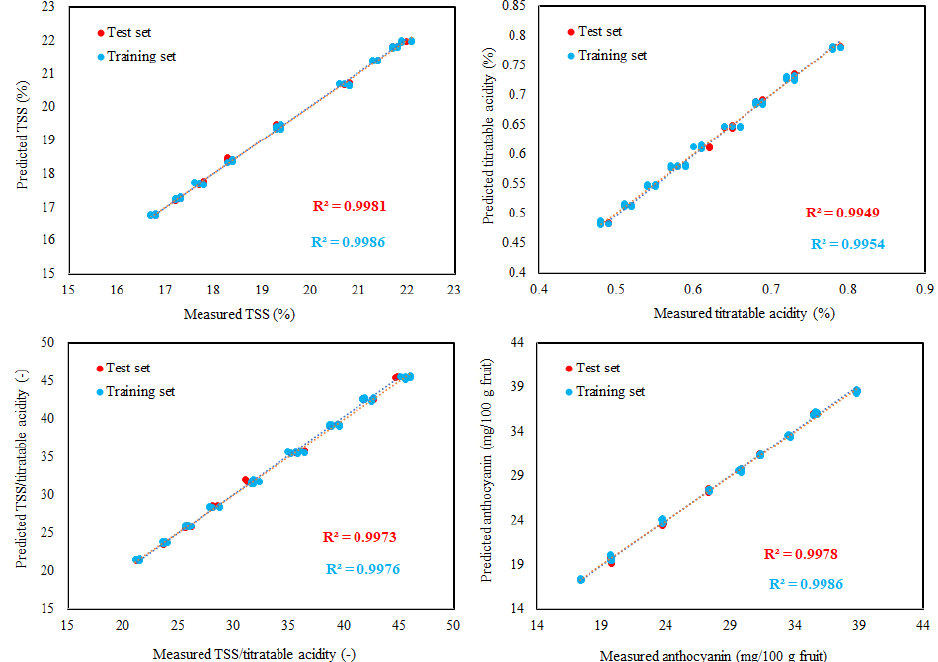
Figure 5. Predicted vs. experimental values of the TSS, titratable acidity TSS/acidity, and anthocyanin using the optimal ANN topology and training and testing sets. The coefficients of determination (R 2 ) are reported.